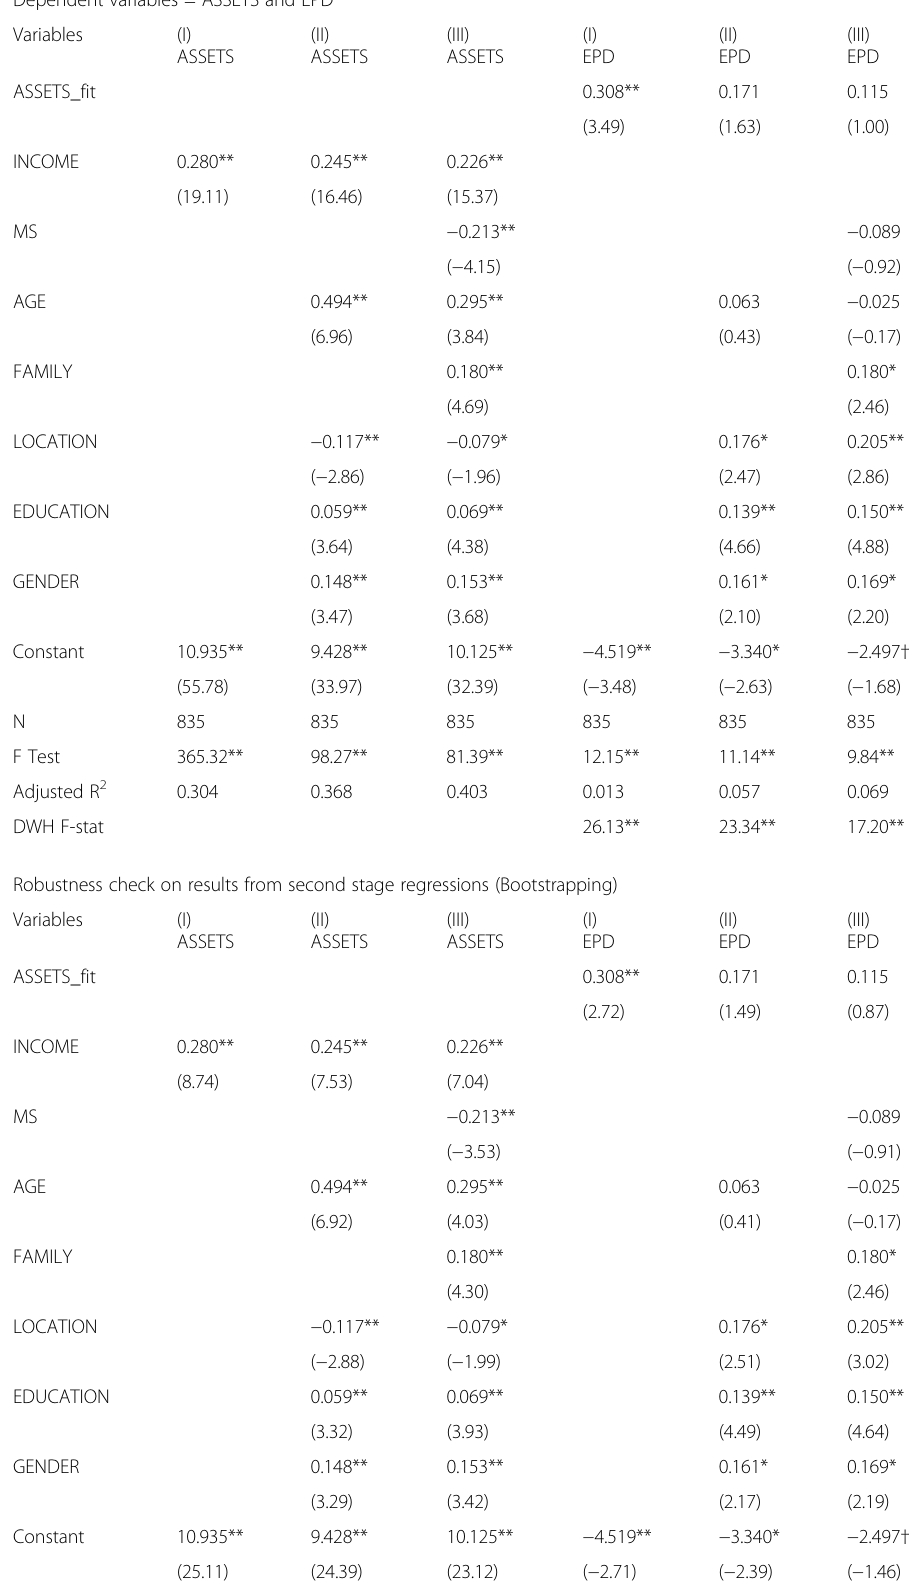
Table 4 Results of second stage regressions and robustness check a Dependent variables = ASSETS and